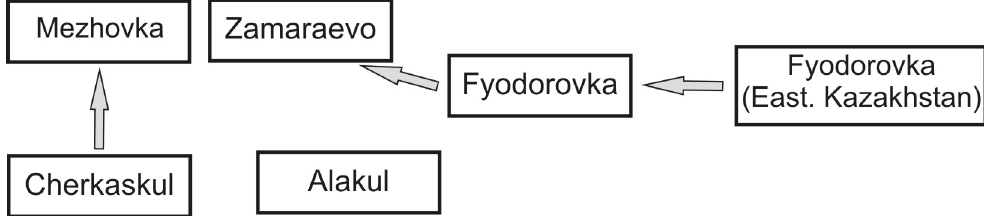
Figure 8: Scheme of Andronovo cultural genesis of V.S. Stokolos (1972).